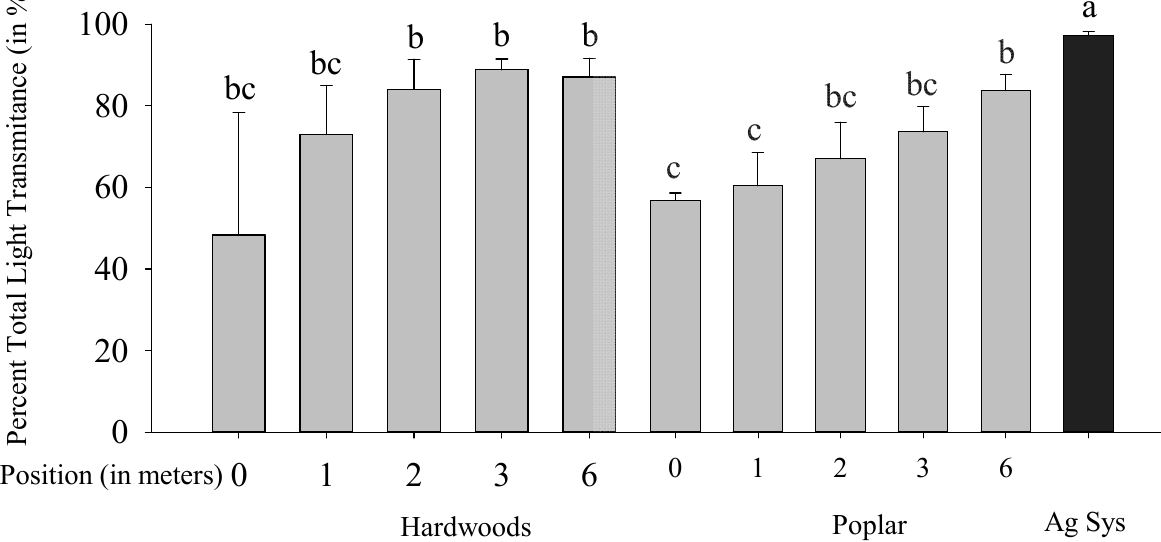
Figure 4. Percent total light transmittance (PTLT) at sampling positions located at 0, 1, 2, 3 and 4 m from the hardwood row, located at 0, 1, 2, 3 and 6 m from the poplar row and in the center of an adjacent agricultural system (Ag Sys) at St. Paulin. The error bars represent standard deviation of the mean ( n = 3). Means with different letters are significantly different at p < 0.05 (Tukey